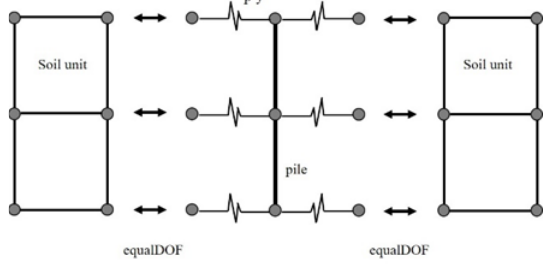
Figure 2. Schematic diagram of soil spring.